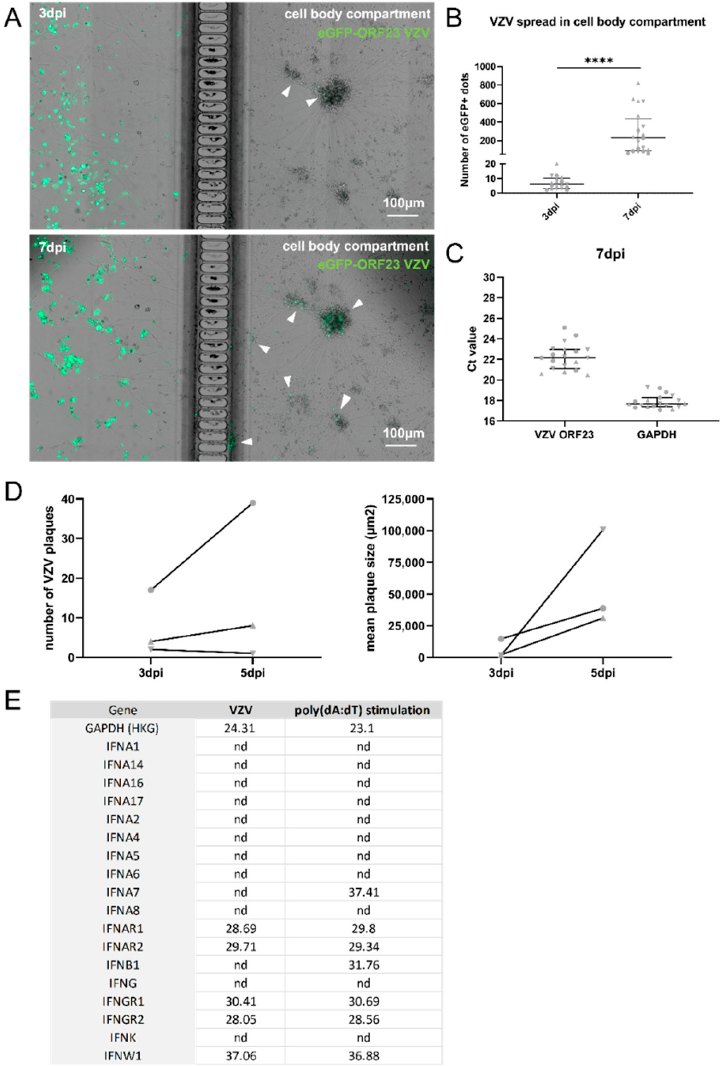
Figure 3. VZV infection of and spreading in neuronal cultures does not trigger type I IFN production. ( A ) Representative images of sections of neuronal cultures at 3 dpi (upper panel) and 7 dpi (lower panel) inoculated at their axon termini with 7.3 × 10 3 PFU ARPE-19-associated eGFP-ORF23 VZV. Arrow heads indicate eGFP+ dots in the neuronal cell body compartment arising from VZV ORF23 expression. ( B ) Quantification of the number of eGFP+ dots arising from VZV ORF23 expression in the cell body compartment at 3 dpi and 7 dpi. Median number of eGFP+ dots across